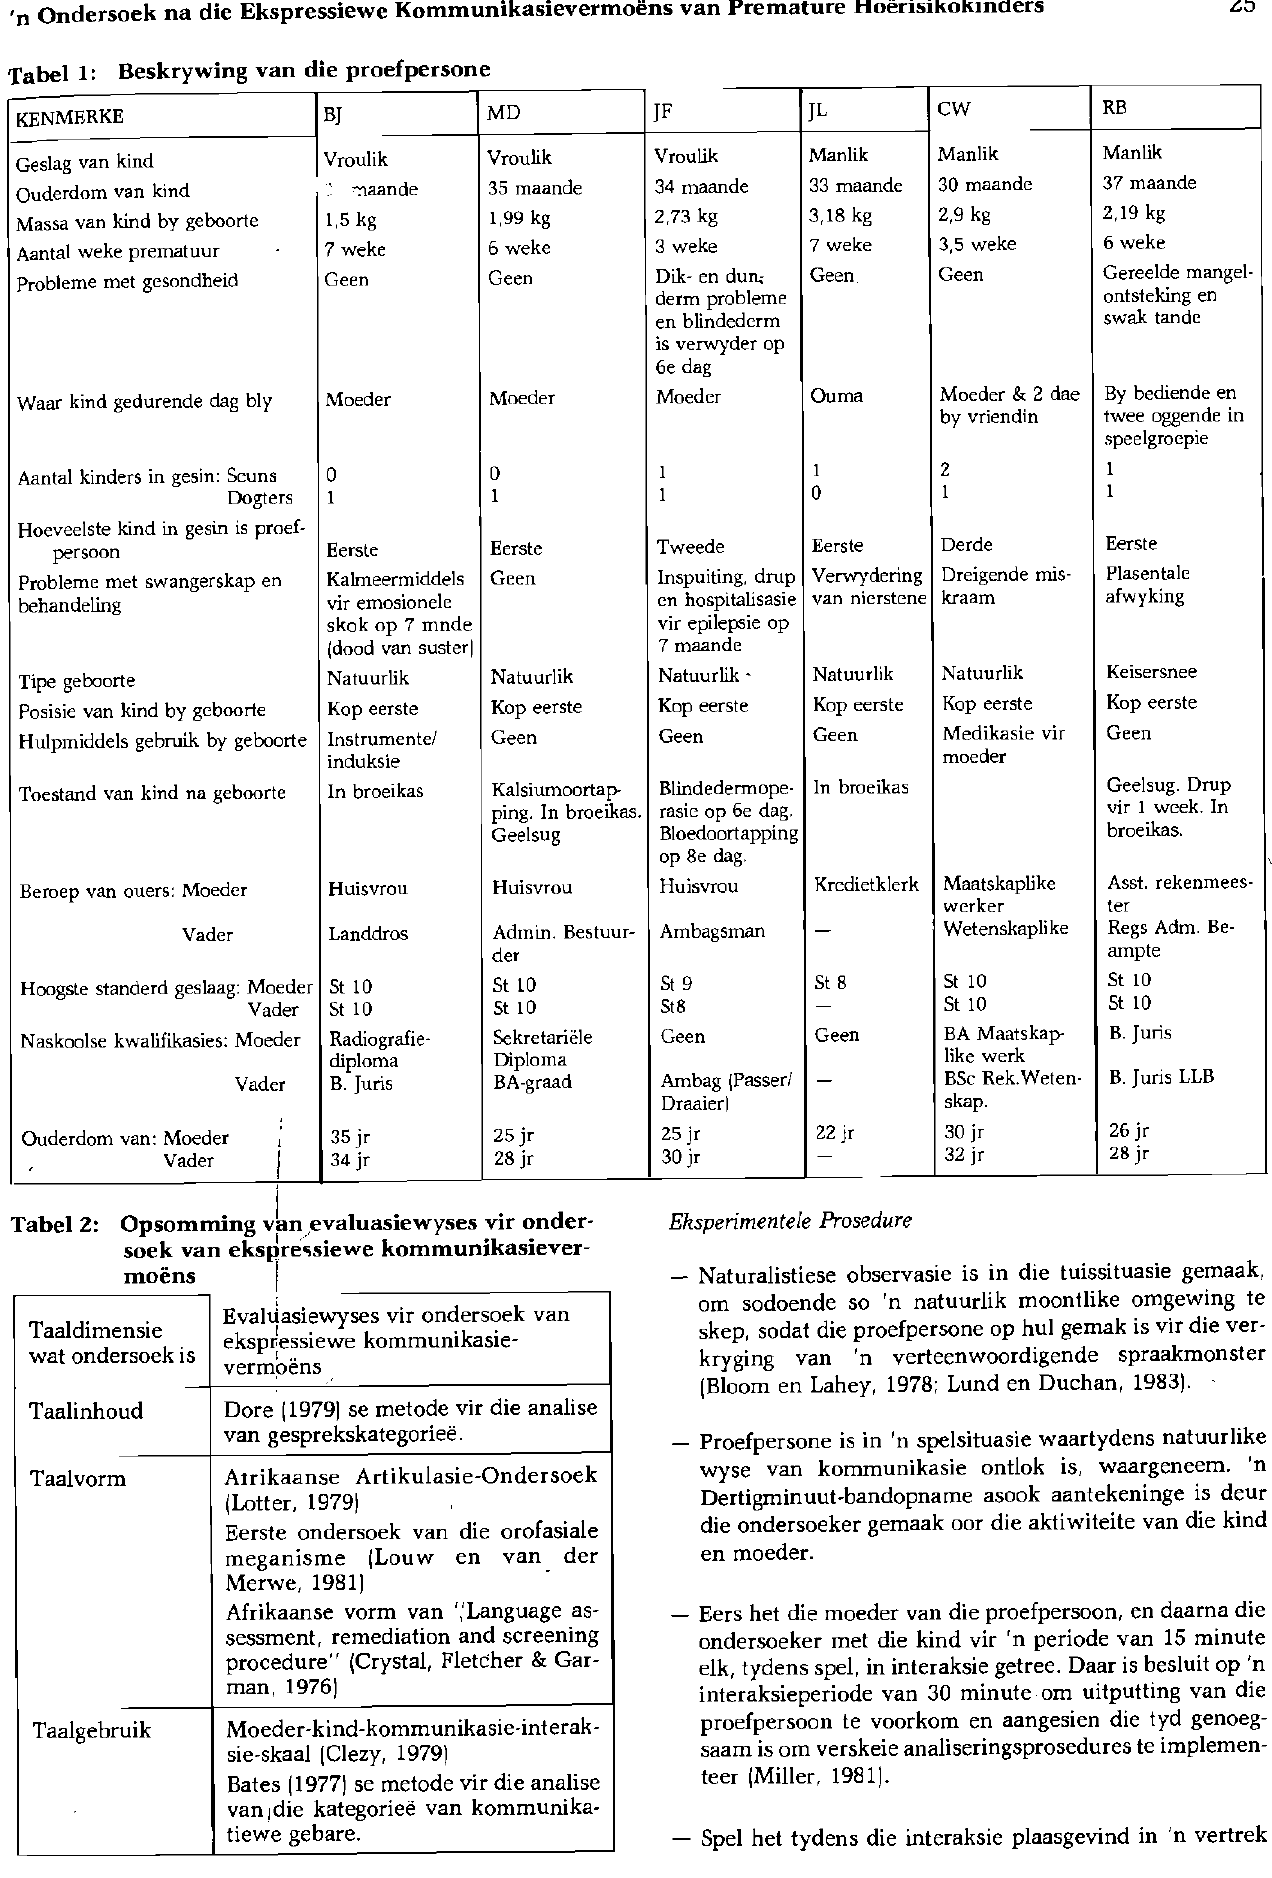
Tabel 1: Beskrywing van die proefpersone